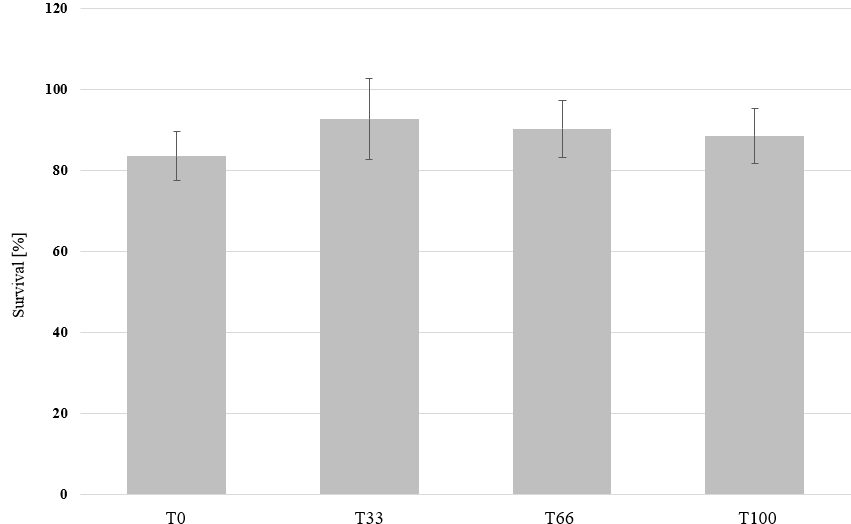
Figure 6. The survival of mealworm larvae grown on substrates that contain different ratios of hemp material. Mealworm larvae were fed with wheat bran (T0), 67% bran and 33% hemp (T33), 34% bran and 66 hemp (T66), or 100% hemp (T100). The survival rate is shown in the graph. One ‐ way ANOVA (n = 5, p < 0.05) revealed no significant differences in survival among the treatments.